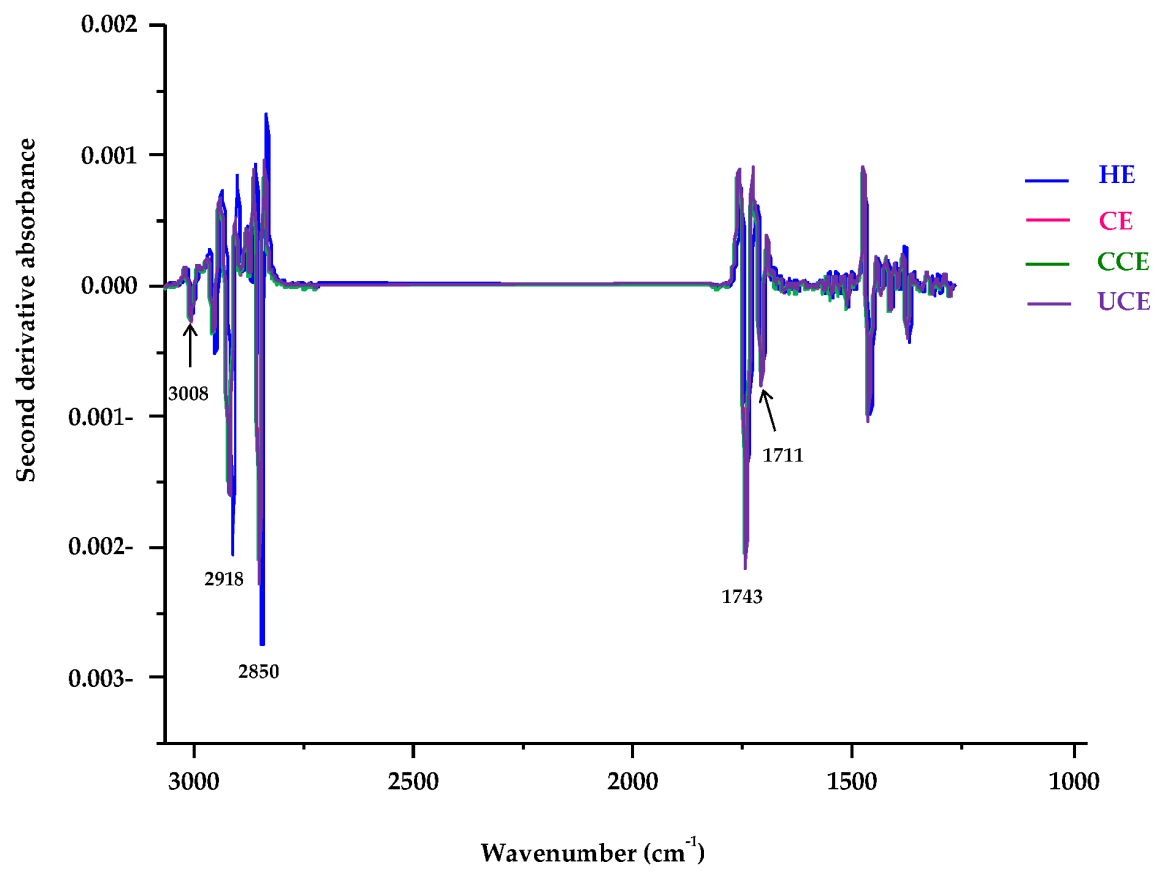
Figure 5. The second derivative SR-FTIR absorption spectra of CRBO in the 3050–1250 cm −1 region. HE: hexane extraction, CE: cold press extraction, CCE: thermally pretreated cold press extraction, UCE: ultrasound-pretreated cold press extraction.